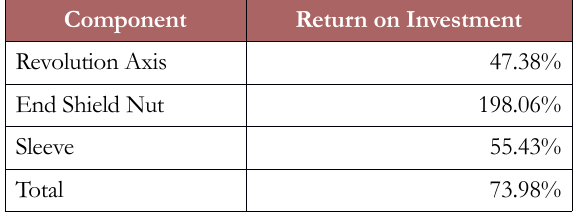
Table 21.ROI in supplier side